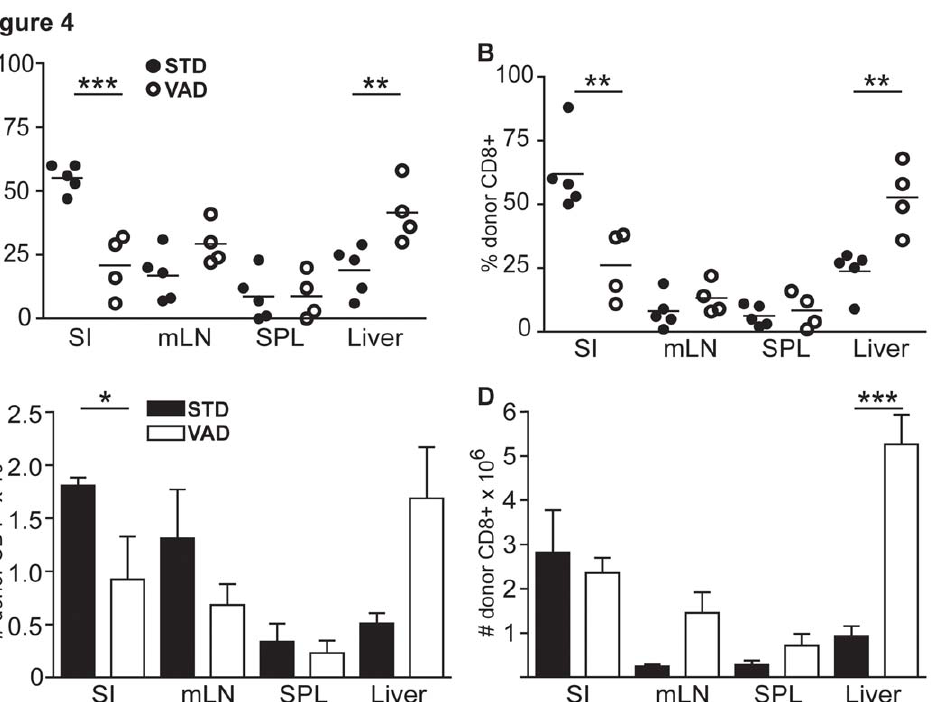
Figure 4. Reduced accumulation of donor T cells in the intestine and increased accumulation of donor T cells in the liver of VAD recipients during acute GvHD. Mice were analyzed for donor T cell (Thy1.1) occurrence in SPL, mLN, liver and small intestine (SI) at day 21 after transplantation. (A) Each dot represents the percentage of infiltrating Thy1.1 + CD4 + T cells of all Thy1.1 + CD4 + T cells. (B) Each dot represent the percentage of infiltrating Thy1.1 + CD8 + T cells of all Thy1.1 + CD8 + T cells. Bars indicate mean values. N=4–5/group. **: p , 0.01; ***: p , 0.001. Data are combined from two independent experiments. (C) Each bar represents absolute numbers of infiltrating Thy1.1 + CD4 + T cells from STD or VAD recipients. Bars indicate mean values. N=4–5/group. **: p , 0.01; ***: p , 0.001. Data are combined from two independent experiments. (D) Each bar represents absolute numbers of infiltrating Thy1.1 + CD4 + T cells from STD or VAD recipients. Bars indicate mean values. N=4–5/group. **: p , 0.01; ***: p , 0.001. Data are combined from two independent experiments.